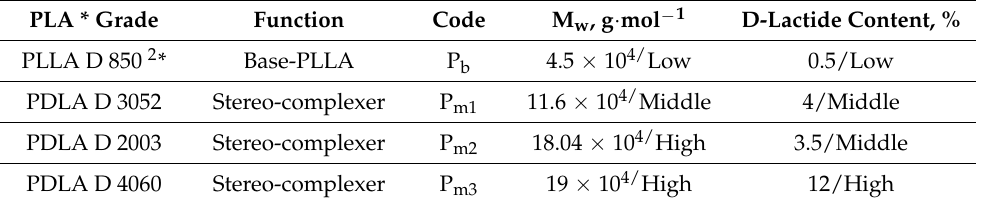
Figure 1. Complete study design for achieving racemized PLLA with functional properties required by 3D printing automotive applications. Table 1. Characteristics of the PLA grades used for stereo-complexation.